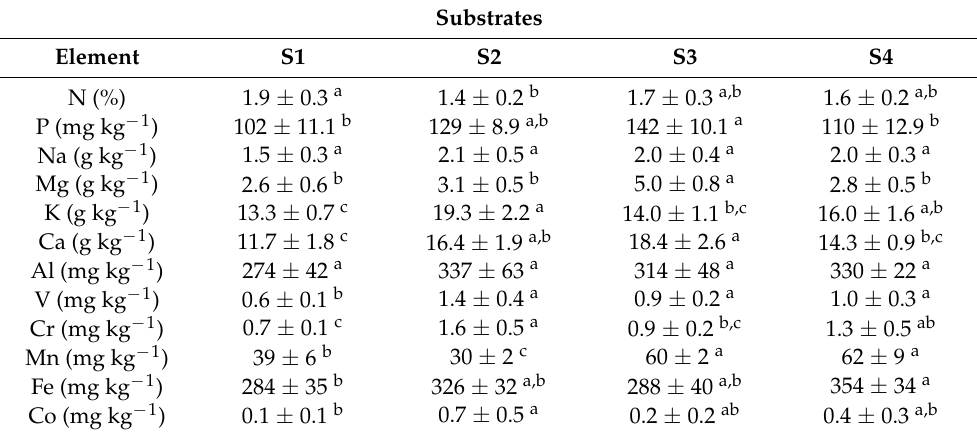
Table 3. Leaf elemental composition (%, mg kg − 1 or g kg − 1 of dry matter) of sage plants grown in the four